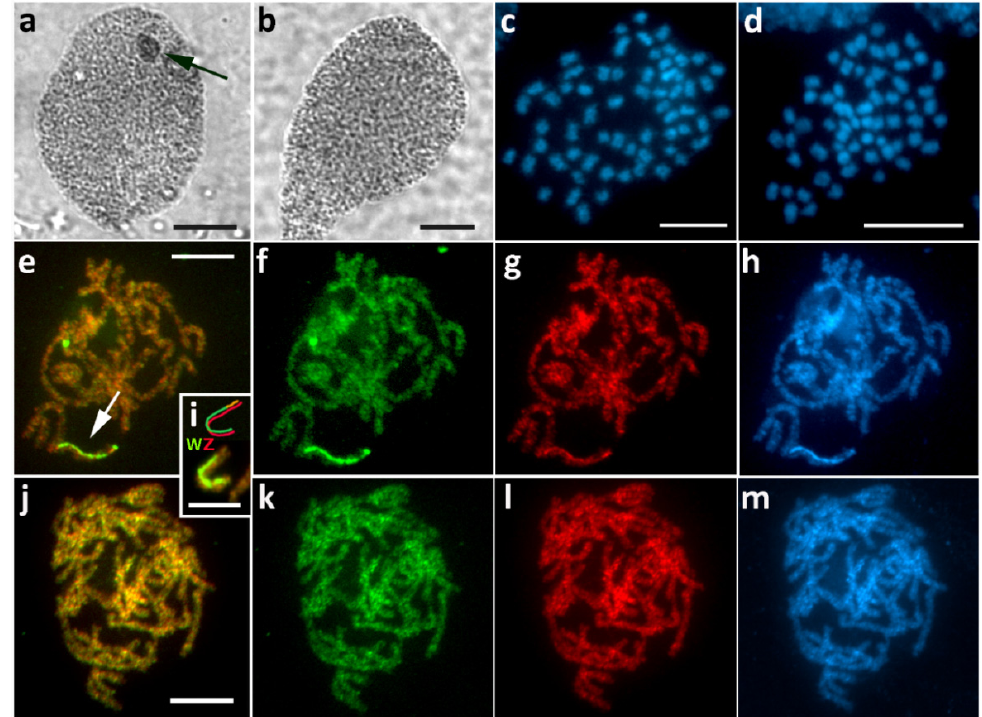
Figure 8. WZ sex chromosomes of Peribatodes rhomboidaria with W enriched in female-specific sequences . ( a , b ) Polyploid nuclei stained with orcein showing conspicuous sex chromatin in females ( a ) but not in males ( b ). ( c , d ) Mitotic metaphase chromosomes stained with DAPI showing 2 n = 62 in both females ( c ) and males ( d ). ( e – i ) CGH on female pachytene chromosomes identified a WZ bivalent with a well-differentiated, DAPI-positive W chromosome, strongly labeled by the female genomic probe except for the terminal region ( e , arrow; i and scheme). ( j – m ) CGH on male pachytene chromosomes without any differentiated region. Panels ( e , i , j )—merged pictures of both genomic probes; ( f , k )—female genomic probe (green); ( g , l )—male genomic probe (red); ( h , m )—DAPI staining (light blue). Bar = 10 µm.